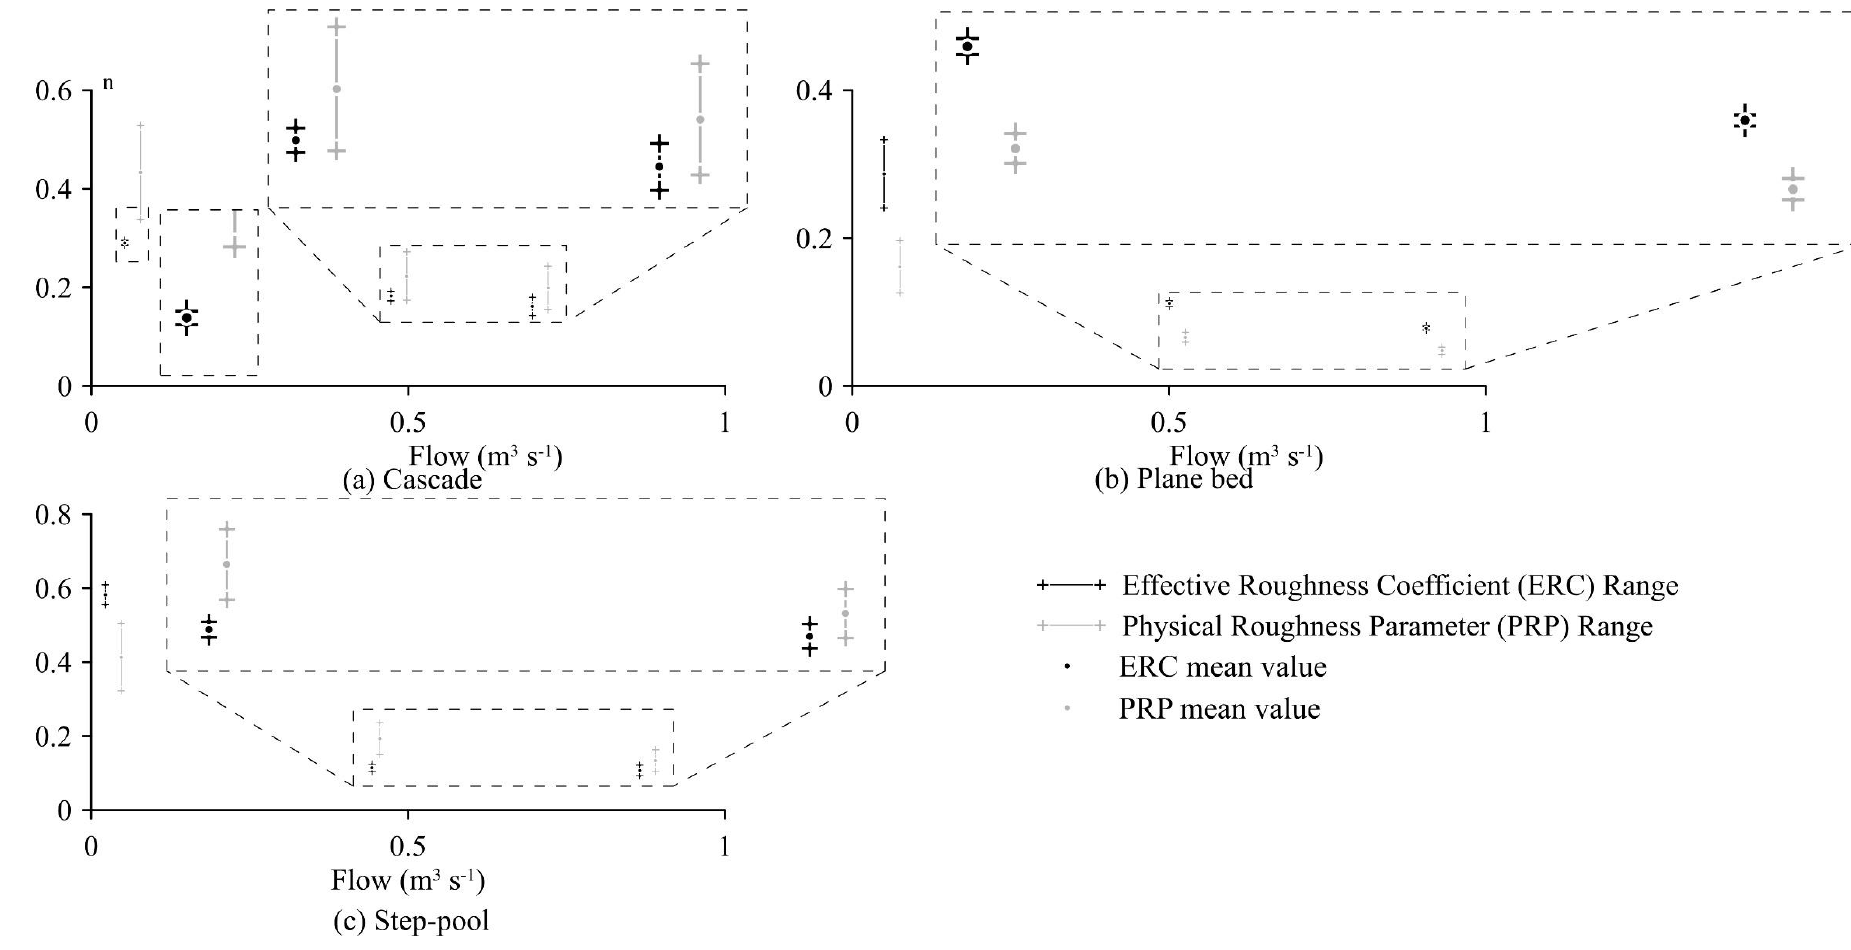
Figure 6. Comparison of measured and calibrated n values. ( a ) Cascade; ( b ) Plane bed; ( c ) Step-pool.